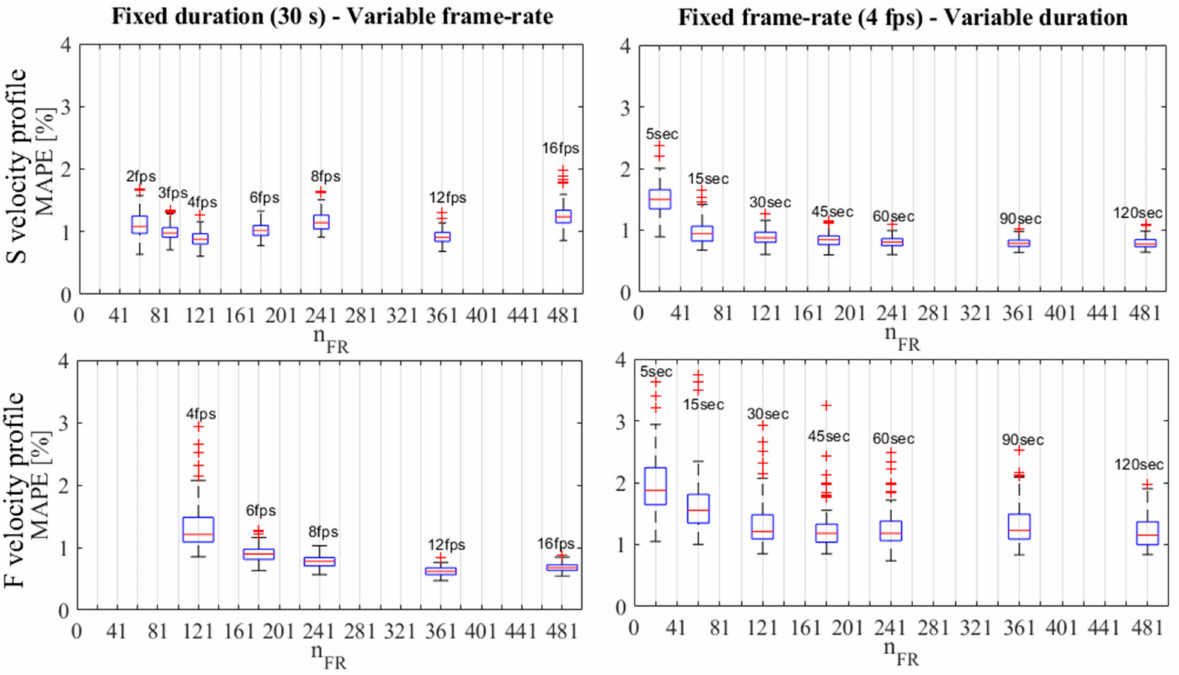
Figure 11. Left panels refer to the analysis with fixed duration ( d = 30 s) and variable frame-rate (whose values are reported as ticks above each box), while right panels refer to the analysis with fixed frame-rate (= 4 fps) and variable d (indicated by ticks above each box). See Table 2 for the corresponding mean frame-by-frame displacements. Top panels refer to the S–velocity cases, while bottom panels to the